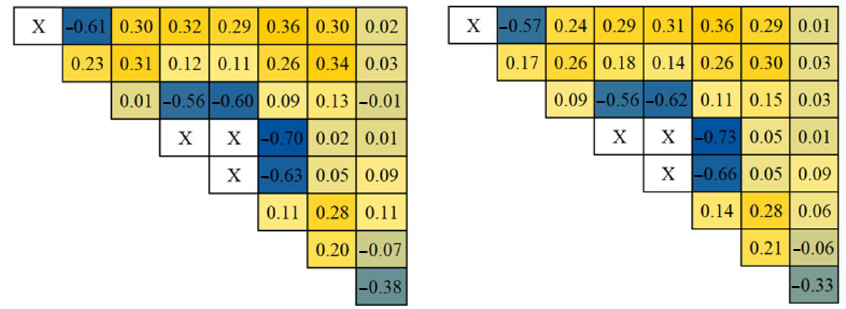
Figure 18. Relative difference [%] in A0 assembly pin powers of MPACT default solution ( left ) and MPACT “fine” solution ( right ) from McCARD solution.